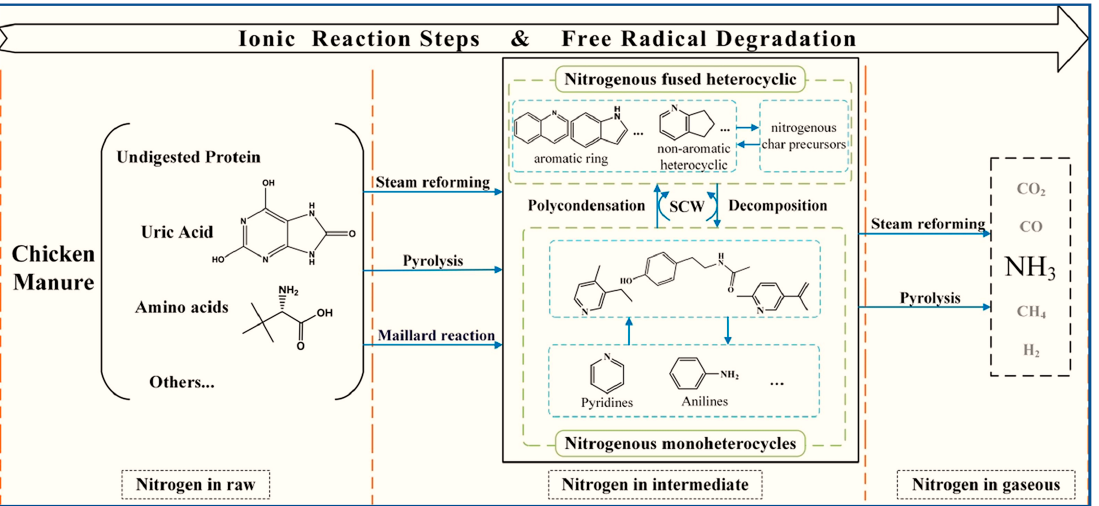
Figure 6. An overview of the reaction mechanism for nitrogen recovery during the hydrothermal gasification of chicken manure. Adapted from Liu et al. [61].